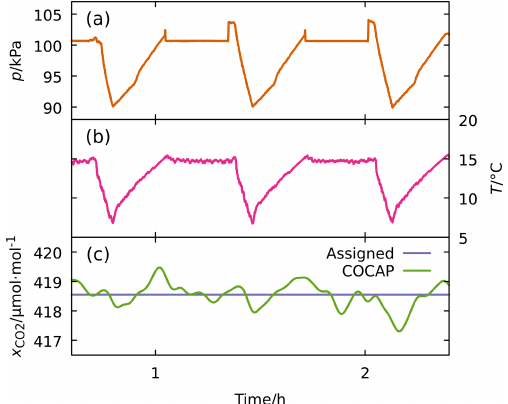
Figure 7. Allan deviation of unfiltered CO 2 dry air mole fraction σ x CO versus averaging period τ . Air from a cylinder was mea- 2 sured under laboratory conditions and during the simulated flights described in Sect 4.1.2. The latter is depicted until τ = 1000s, i.e. one-sixth of the length of the time series. The characteristic − 1 / 2 slope of white noise is indicated by the black line.